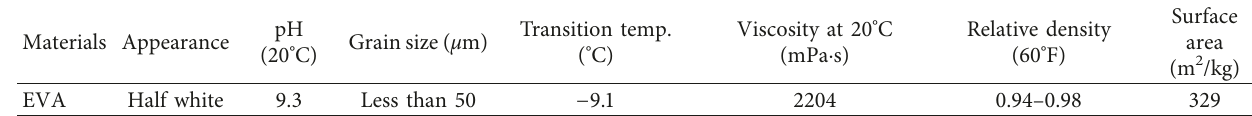
Table 4: Characteristics of EVA.